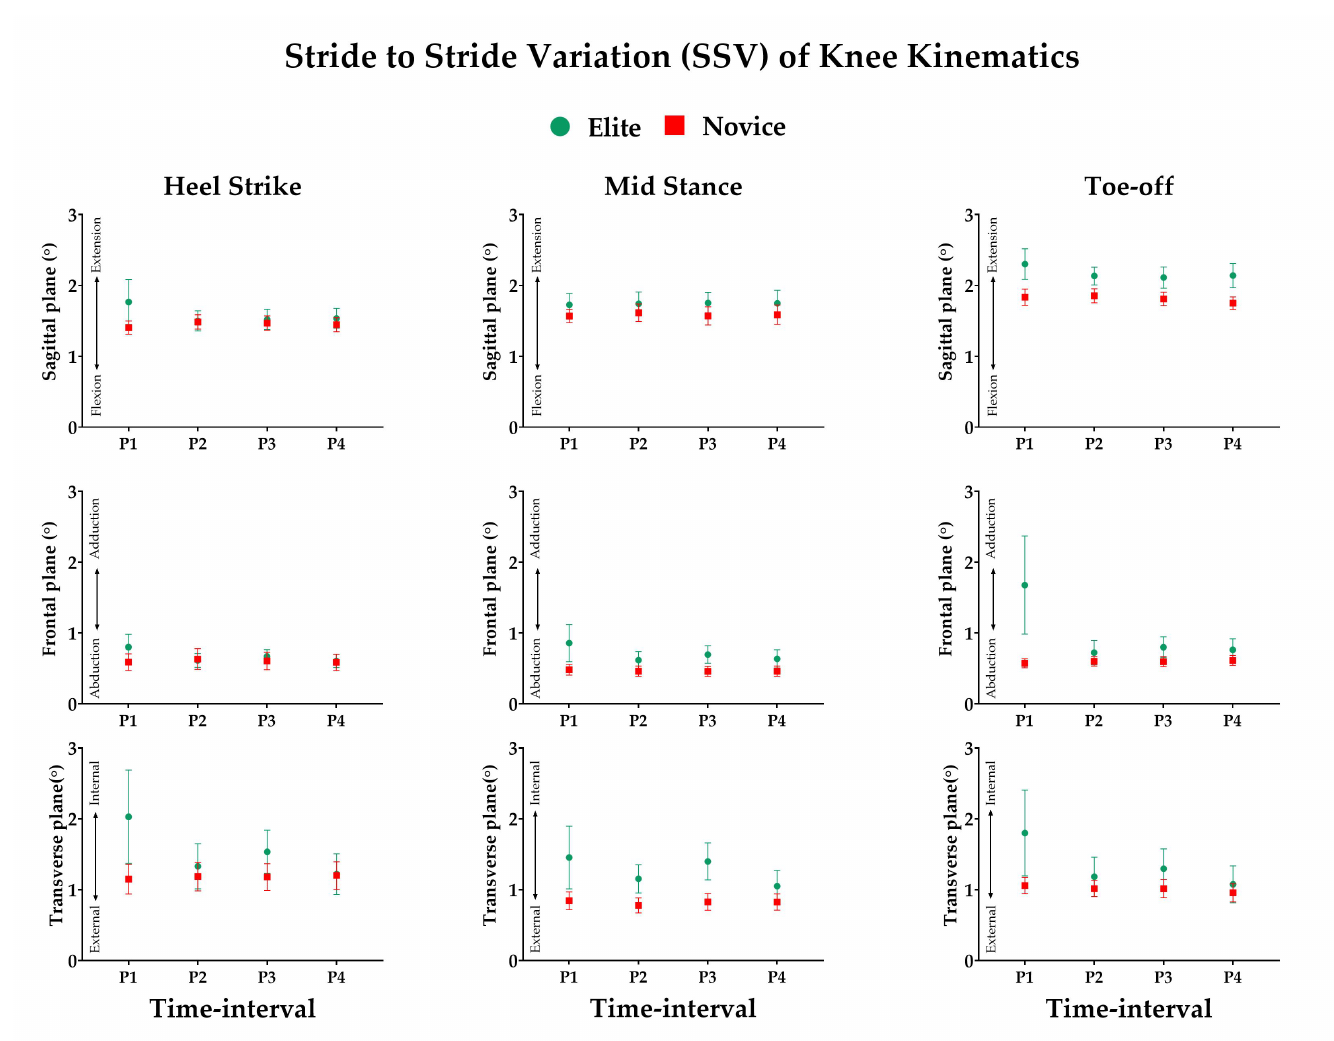
Figure A6. The results of the kinematics of knee joint SSV angle between elites (circle) and novices (square) in each phase of the prolonged run. The computed variable of SSV is represented on the Y -axis. The time-interval calculated by increasing the window size every five minutes is represented on the X -axis (P1: 0 to 5 min; P2: 0 to 10 min; P3: 0 to 15 min; and P4: 0 to 20 min). The figure depicts a significant main effect of group, time interval, and interaction. (Note: only results with significant interaction have been